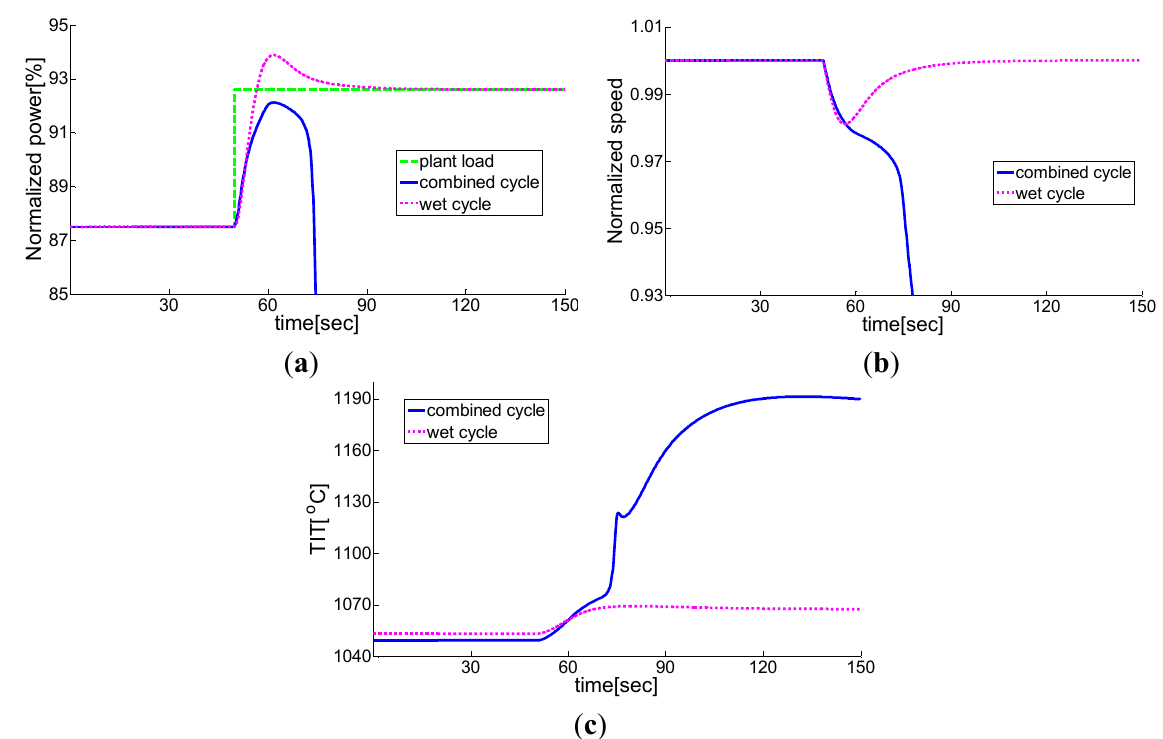
Figure 6. Performance of the combined cycle vs. STIG cycle—5.1% step change load (plant loading from 87.5% to 92.6% of plant load)—combined-cycle instability limit; ( a ) Normalized power, ( b ) Normalized speed, ( c ) Turbine inlet temperature (TIT).